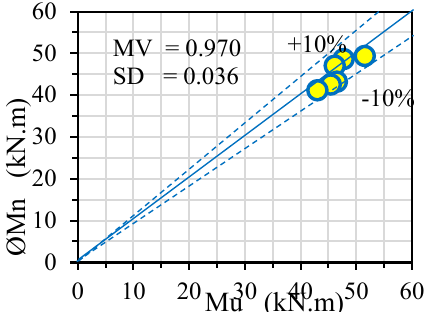
Figure 18. Compare the nominal bending (ØM n ) values with the experimental results (M u ).